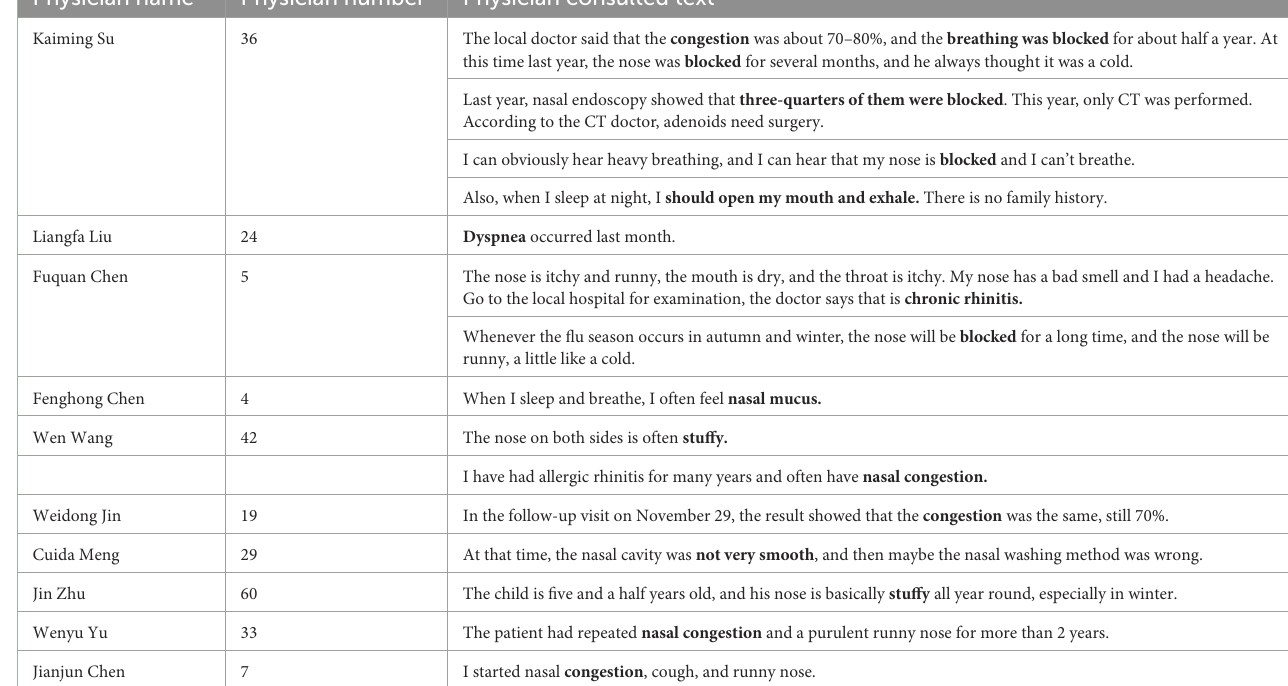
TABLE 14 Recommended results and diagnosis information of target patient